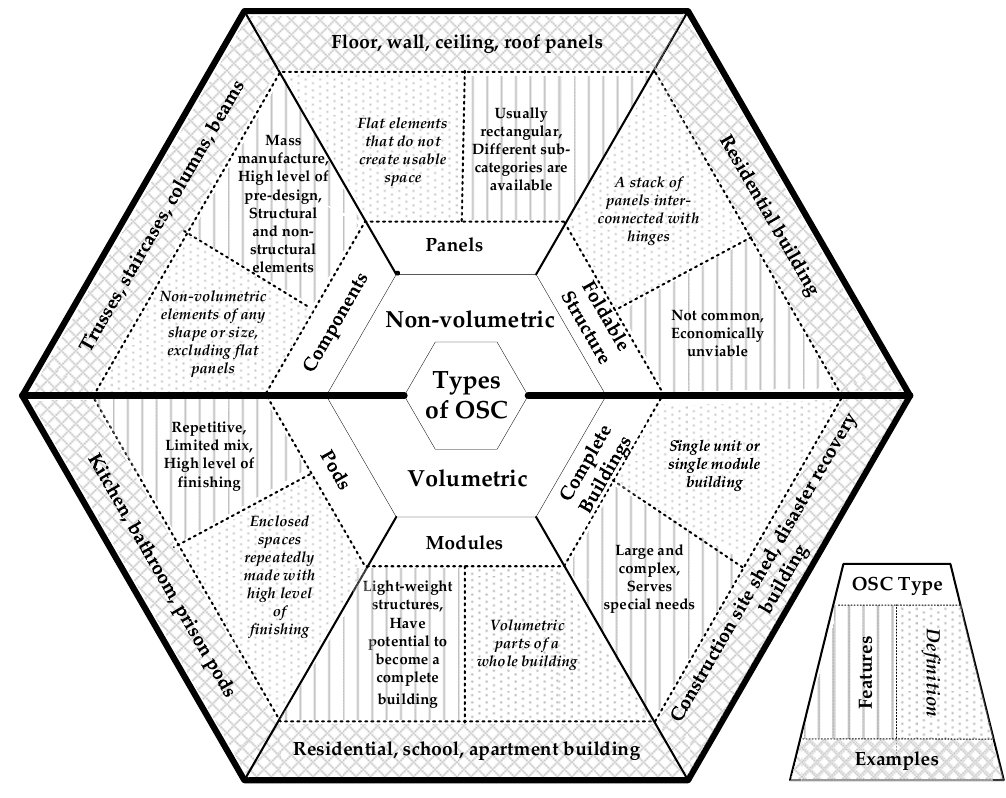
Figure 3. Definitions, examples, and features of the validated OSC